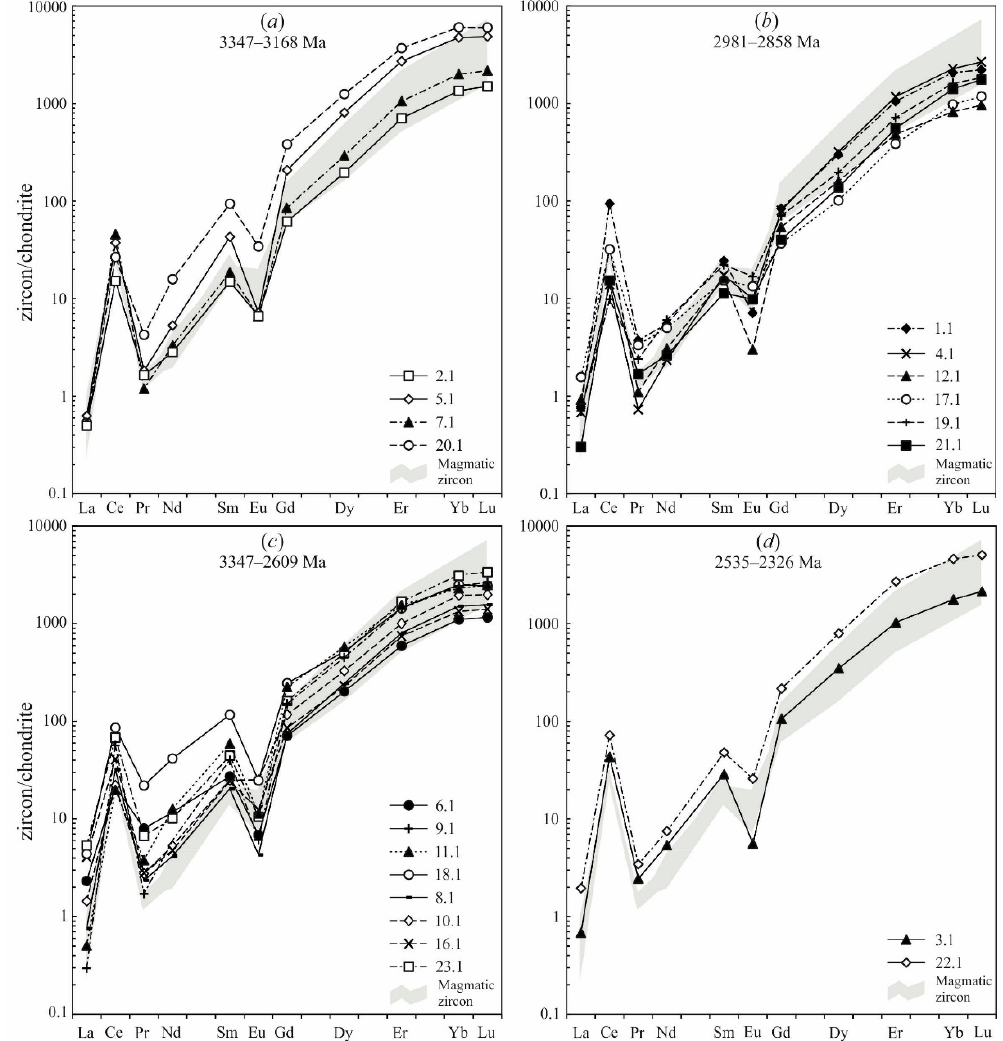
Figure 10. ( a – d )—Chondrite-normalized REE patterns of zircons from the quartzite, sample 523. Pattern numbers correspond to the numbers of analytical spots in Figure 9. The grey field corresponds to the composition of magmatic zircons according to [29].